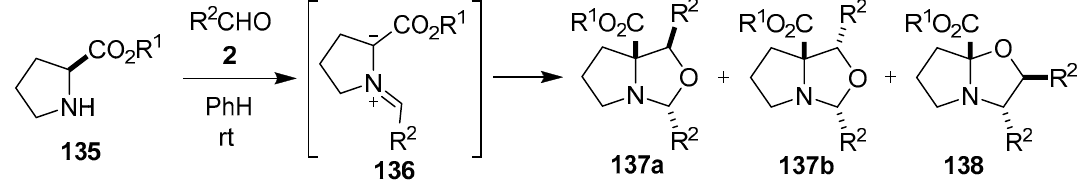
Table 19. Cycloaddition of azomethine ylide 136 to aldehydes 2 (Scheme